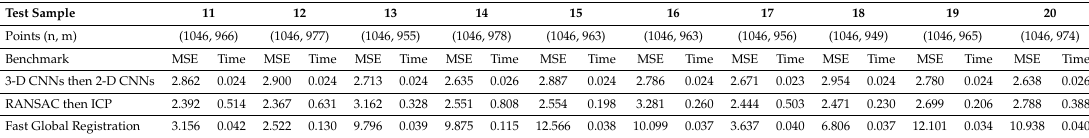
Table 10. The comparisons about MSE and computation time of “Armadillo” data for test samples from 11 to 20.